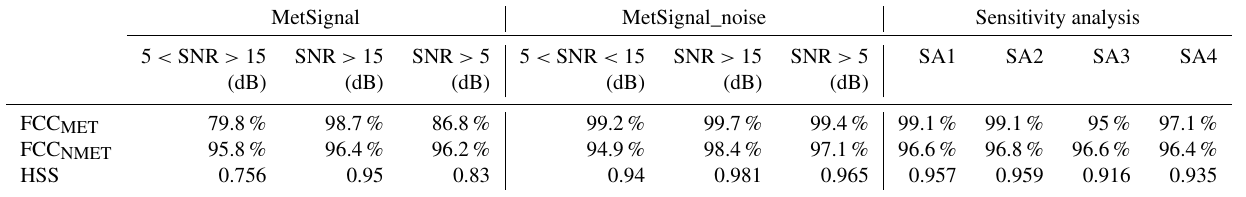
Figure 12. (a) A MET (MetSignal_noise) after post-processing; (b) A MET (MetSignal_noise) before post-processing; (c) MetSignal_noise; (d) Z ; (e) ZDR; and (f) CC. All from NUIST-CDP at 10:49UTC on 23 May 2017 from an elevation of 2.4 ◦ . Table 5. The classification performance of MetSignal and MetSignal_noise algorithms, and the sensitivity analysis of different improvement steps in MetSignal_noise algorithms. All skill scores were computed based on data in the test set. MetSignal MetSignal_noise Sensitivity